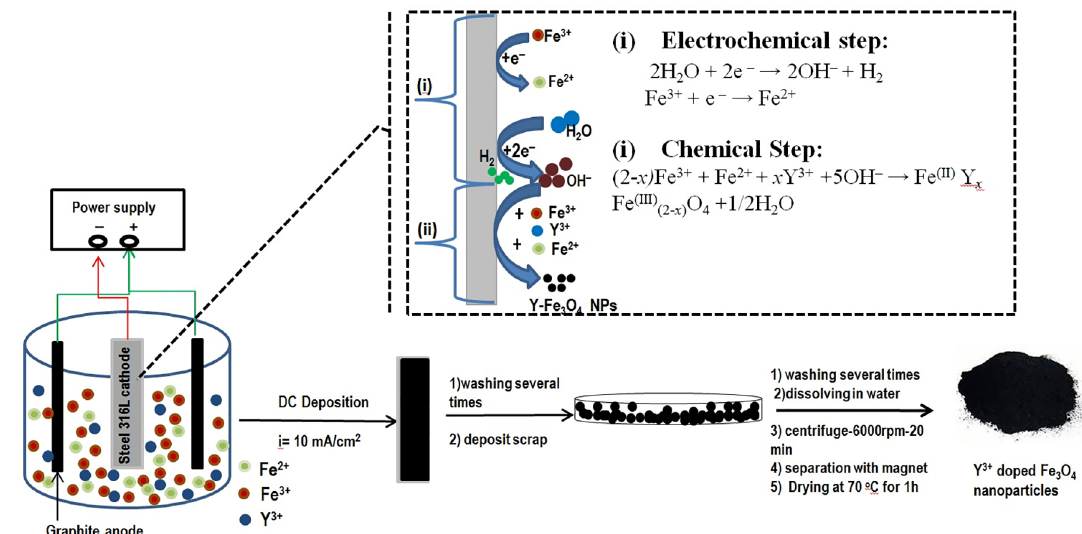
Fig. 1. Schematic graph of the cathodic electrodeposition of Y 3+ doped IONPs. The inset presents (i) electrochemical and (ii) chemical steps of deposition